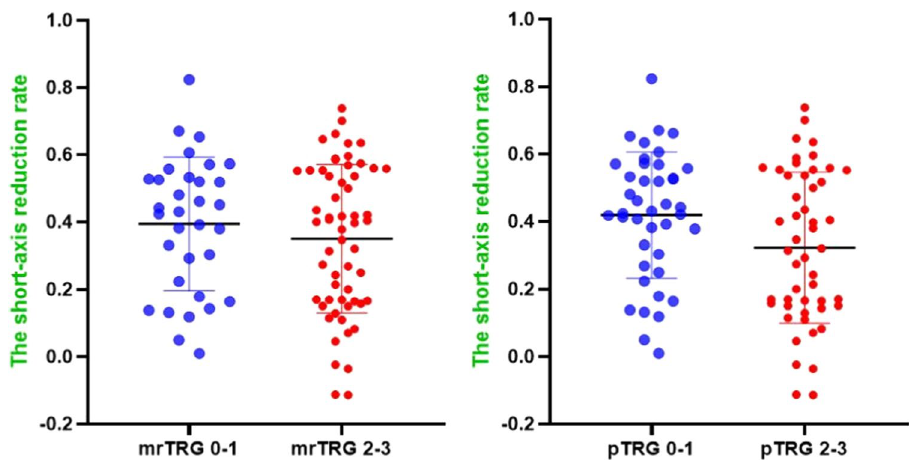
Fig. 4 Scatter diagram of the short-axis reduction